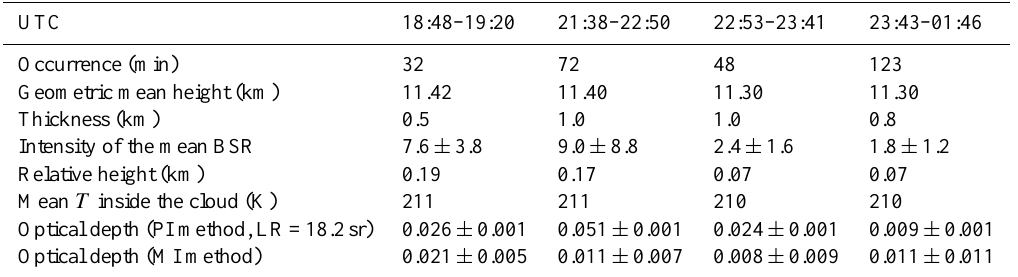
Table 3a. Characterization of cirrus quasi-stationary periods identified at OHP through principal lidar parameters. Temperature values are derived from the operational radiosoundings launched from Nimes (80km west from OHP).